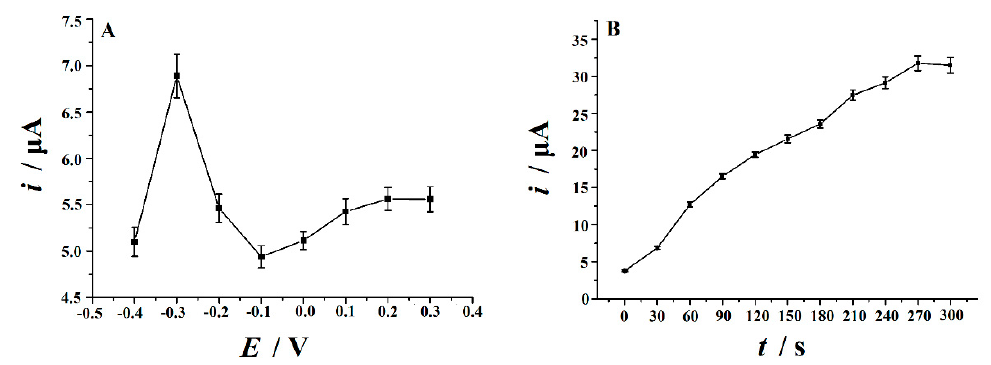
Figure 9. ( A ) Accumulation potential effects and ( B ) accumulation time effects on the peak current of 10 µM rutin in 0.2 M H 2 SO 4 at NH 2 -Fe 3 O4 NPs-ErGO/GCE by SDLSV.